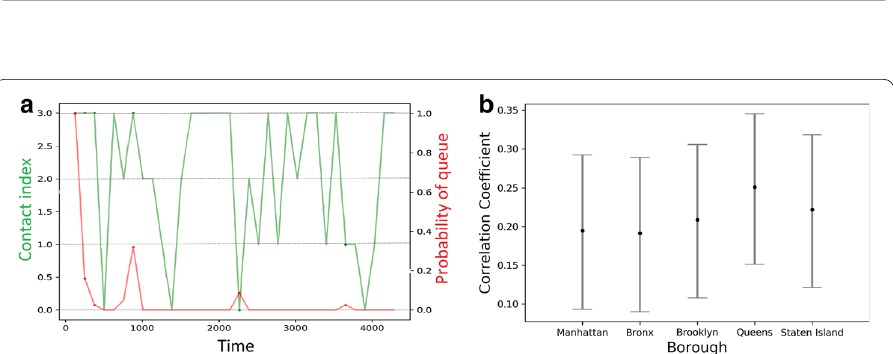
Fig. 5 Adaptive mobility with Q-learning: a Variation in contact index with p queue ; b range of mean Pearson correlation coefficient (with 95% confidence) for the 5